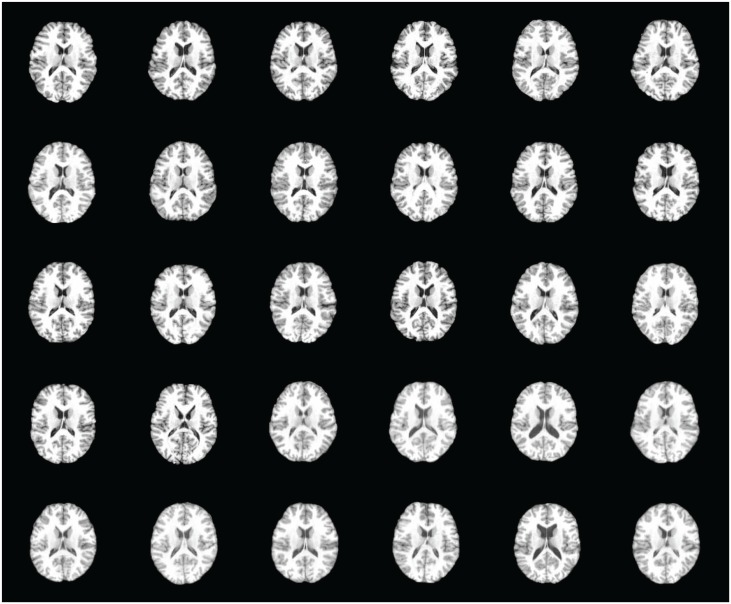
30 IXI MR images.